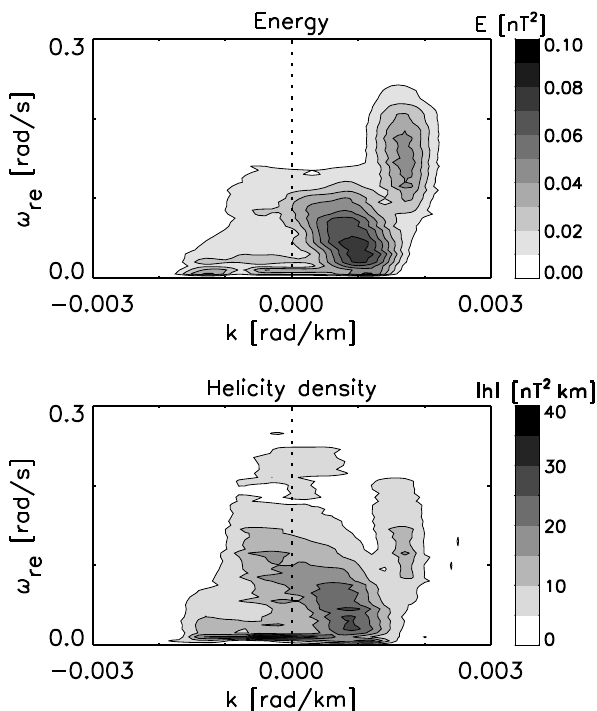
Fig. 6. Energy and helicity density in the frequency-wavenumber domain for a synthetic data set of four-point measurements of mag- netic field (Narita et al.,